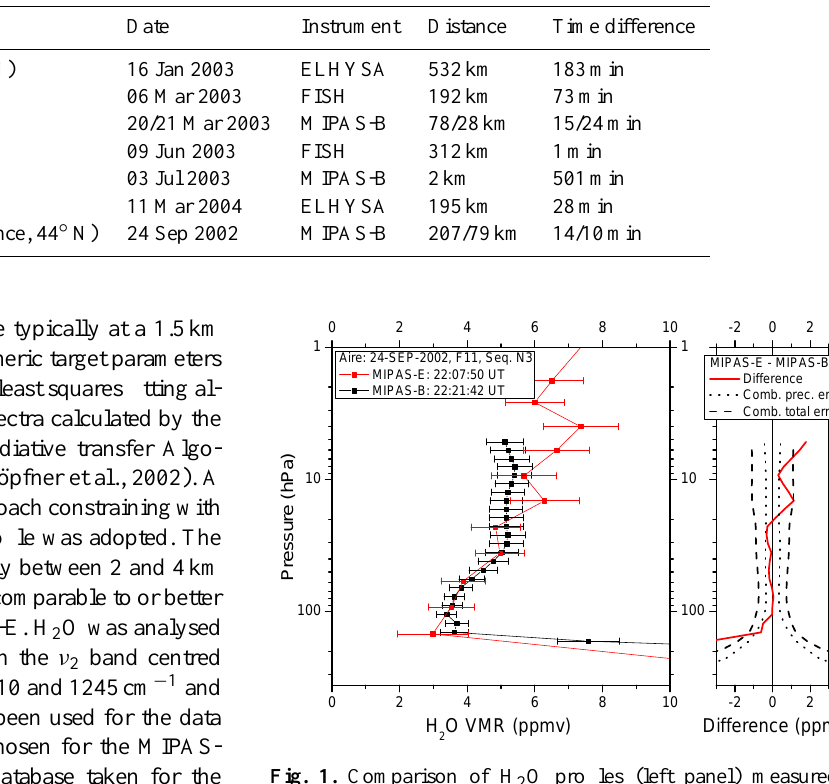
Fig. 1. Comparison of H 2 O profiles (left-hand) measured by MIPAS-B (flight no. 11, sequence N3, black squared line) and MIPAS-E (orbit 2975, red squared line) on 24 September 2002 above southern France along with difference (right-hand, red solid line) and 1 σ combined precision (black dotted lines) and total errors (black dashed lines). Line styles are shown in the figure legend.